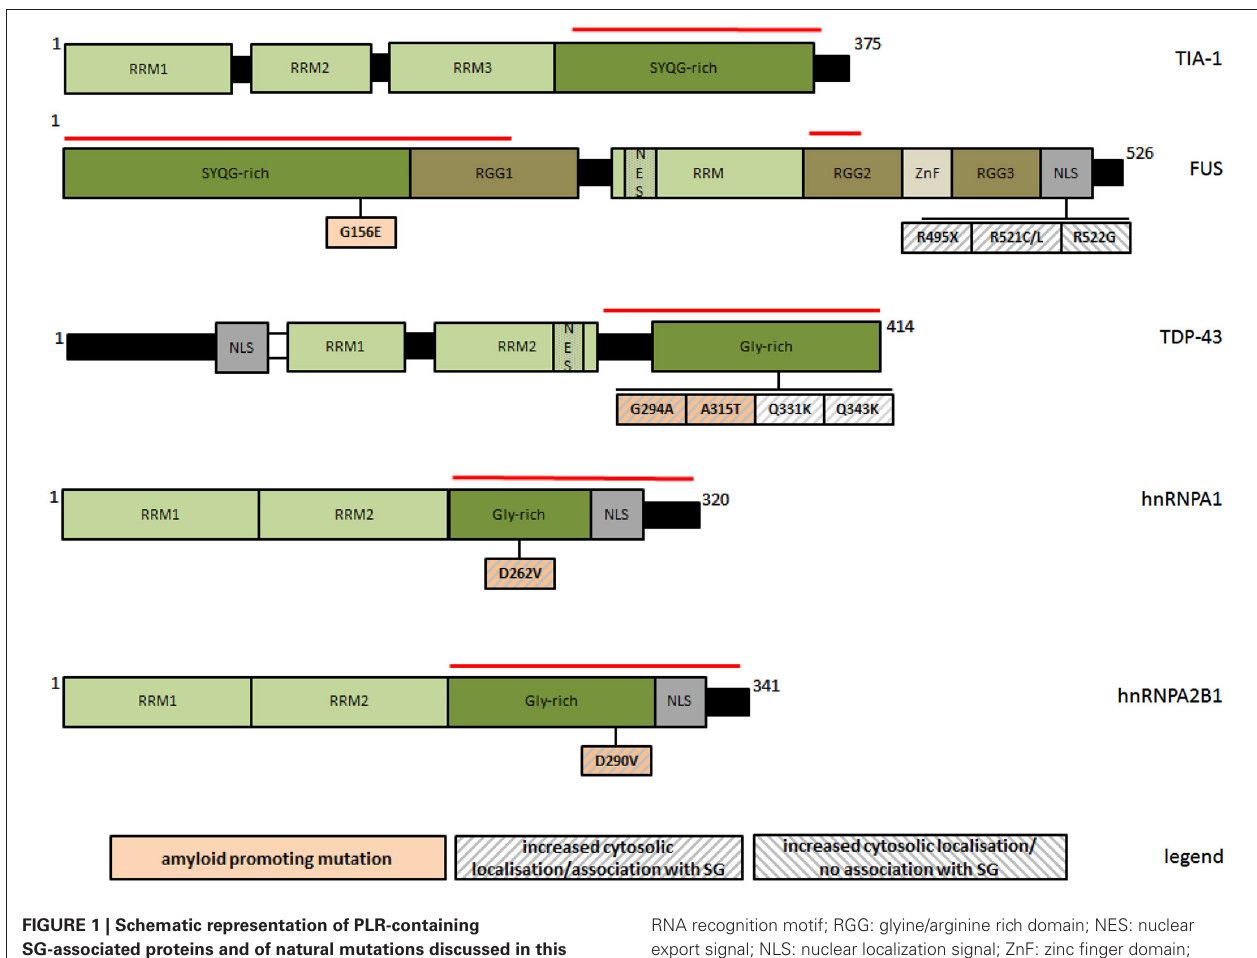
FIGURE 1 | Schematic representation of PLR-containing SG-associated proteins and of natural mutations discussed in this review with respect to their amyloid and SG-modifying properties . The red line marks respective prion-like regions. RRM: